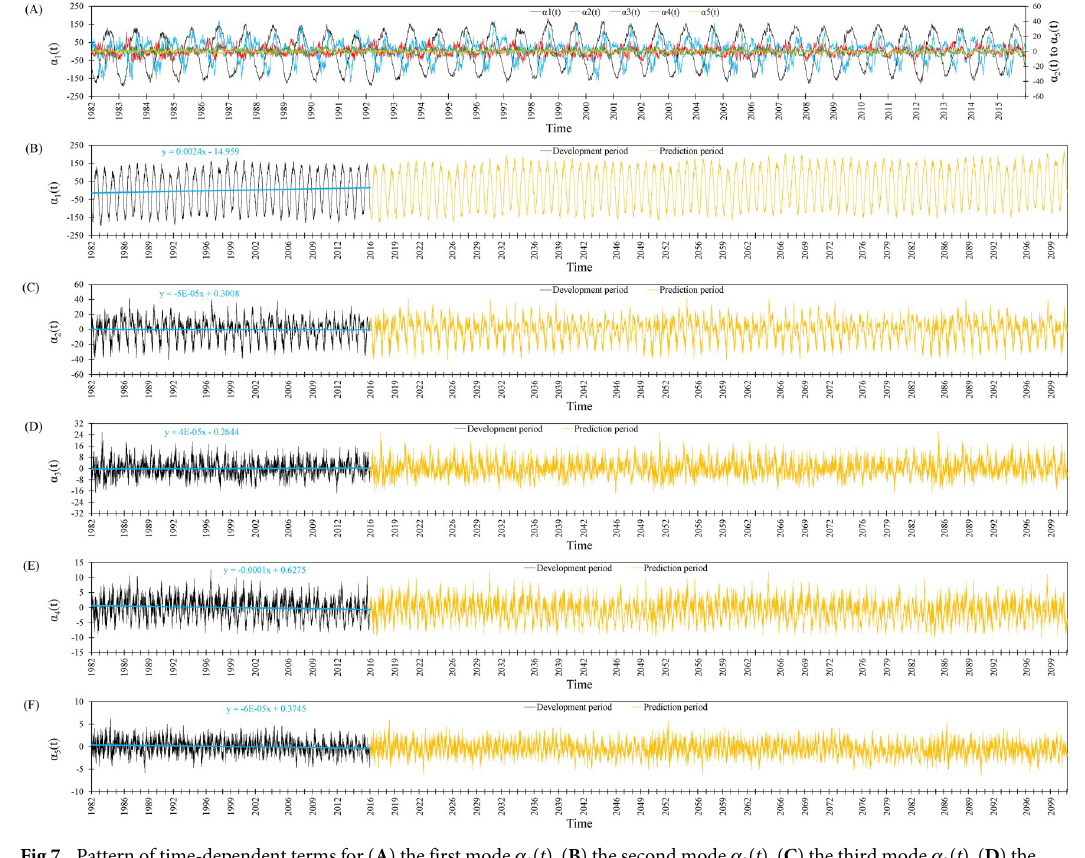
Fig 7. Pattern of time-dependent terms for ( A ) the first mode α 1 ( t ), ( B ) the second mode α 2 ( t ), ( C ) the third mode α 3 ( t ), ( D ) the fourth mode α 4 ( t ), and ( E ) the fifth mode α 5 ( t